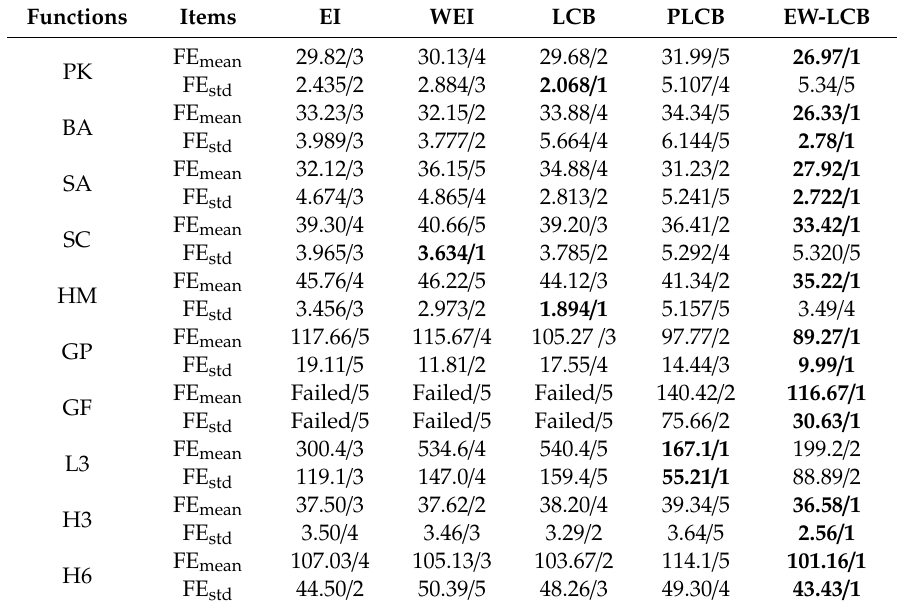
Table 3. The comparison of statistical optimization